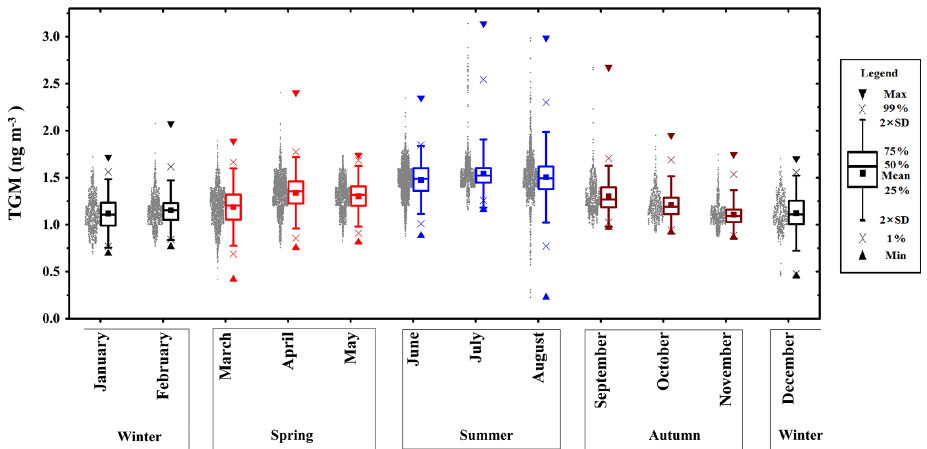
Figure 2. Monthly average and statistical parameters of TGM at Nam Co Station during the whole measurement period (spring (MAM) in red; summer (JJA) in blue; autumn (SON) in dark red; and winter (DJF) in black).